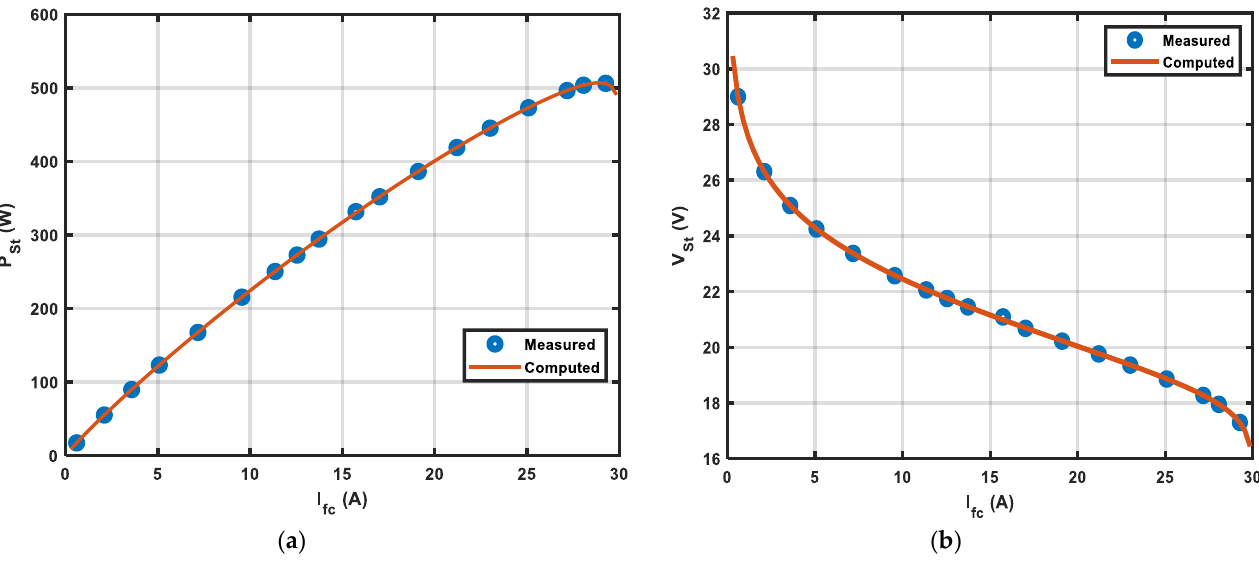
Figure 5. Depiction of I–V and I–P curves obtained using MGTO on test case 1: ( a ) I–P measured against I–P computed, ( b ) I–V measured against I–V computed.